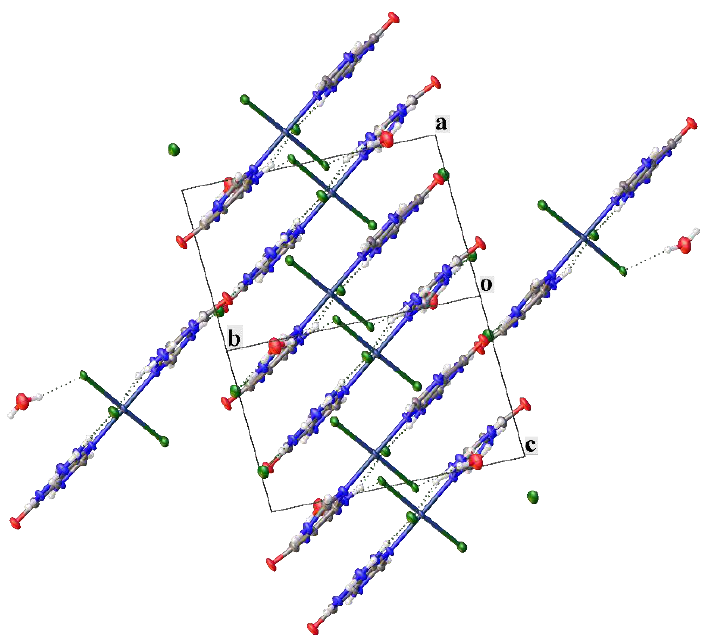
Figure 3. Packing diagram of 1 , view along the [101] direction. 0 indicates the origin of the unit cell and a, b, c — lattice translations.